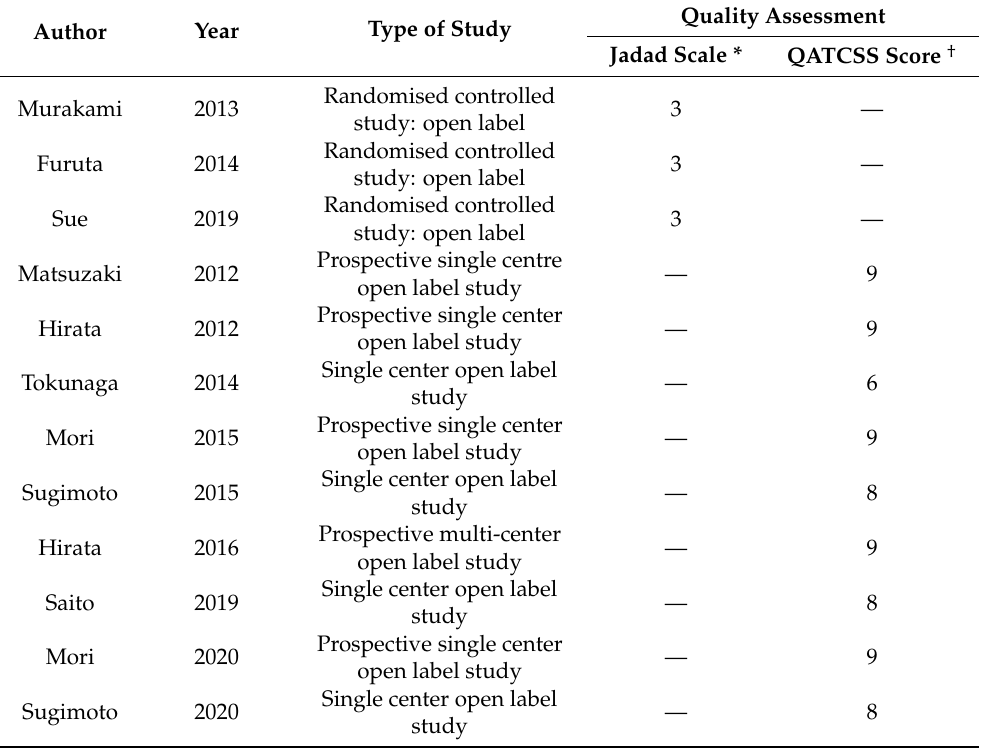
Figure 5. Adverse event (diarrhoea) of 7 days regimen with PPI or vonoprazan (VPZ)–sitafloxacin (STFX)–amoxicillin (AMX). Murakami et al.’s study included other adverse events. RPZ: rabeprazole; LPZ lansoprazole; EPZ: esomeprazole. Table 4. Quality assessment according to type of